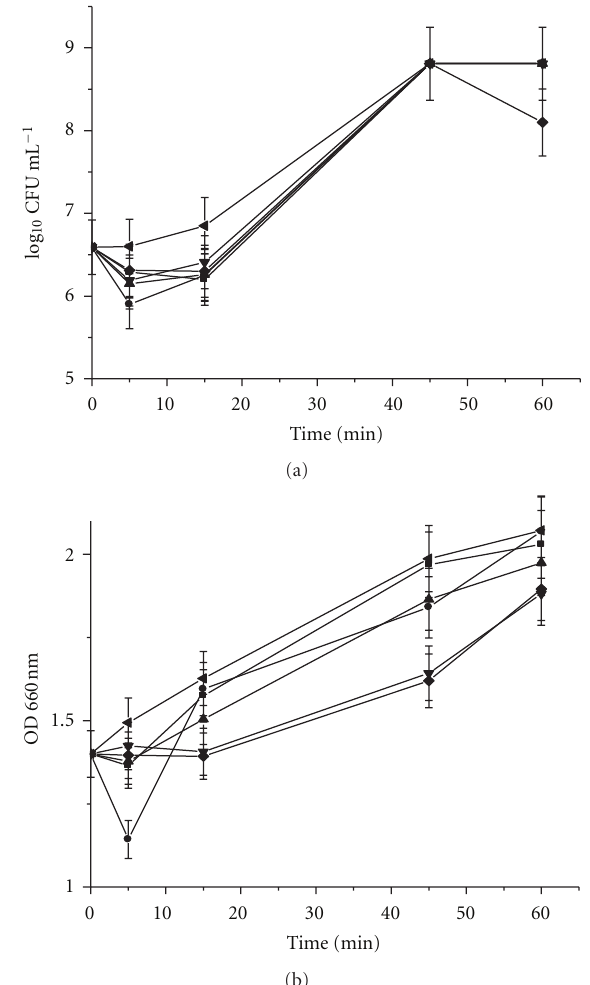
Figure 4: E ff ect of bacteriocins produced by B. thuringiensis on the growth of Salmonella sp. (a) Log 10 cfumL − 1 (b) optical density measured at 660 nm. The five bacteriocins were added in the middle of the logarithmic phase of growth curve ( ∼ 3 h) of Salmonella sp. culture (indicator strain) used as control (without